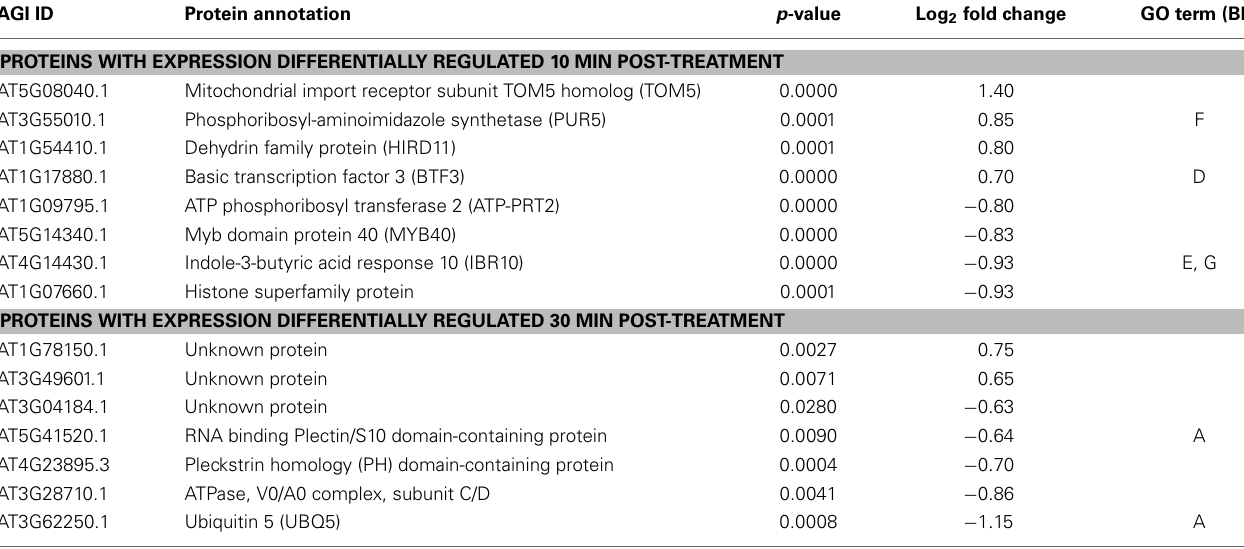
Table 2 | Annotation of proteins differentially expressed 10 and 30min after treatment of cells with 10 pM AtPNP-A